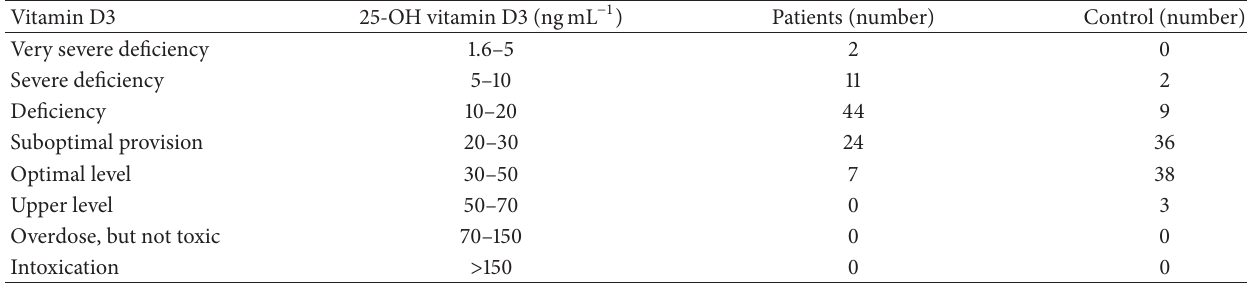
Table 3: Serum 25-OH vitamin D3 concentration in patients and healthy donors.